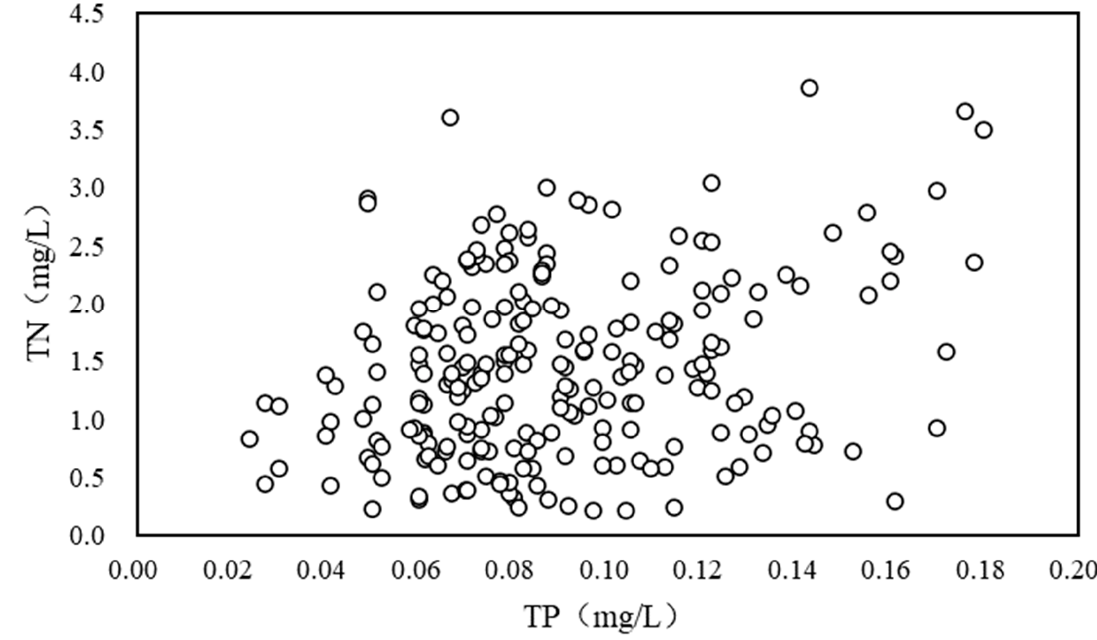
Figure 1. Total phosphorus (TP) and total nitrogen (TN) contents in waters of shallow lakes of the middle and lower reaches of the Yangtze River based on literature data (Table S1).